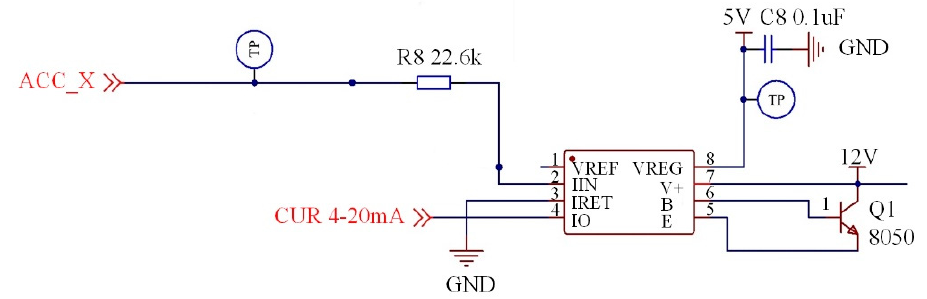
Figure 5. Circuit diagram of the XTR115.